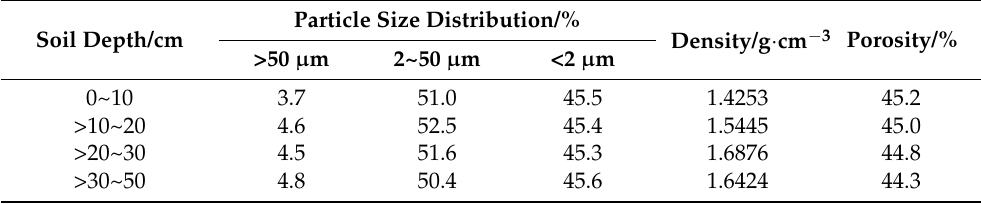
Table 1. Physical soil properties in the experiment area.